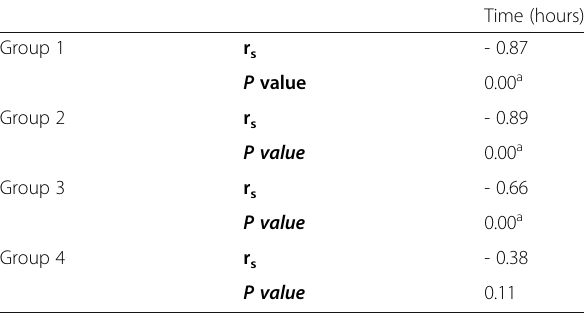
Table 2 Spearman Correlation between brain GAPDH & TIME intervals in different